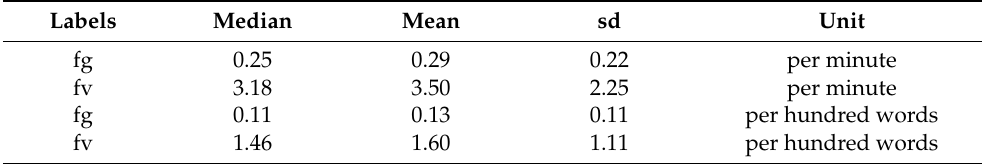
Table 3. Median, mean, and standard deviation (sd) in BeDiaCo